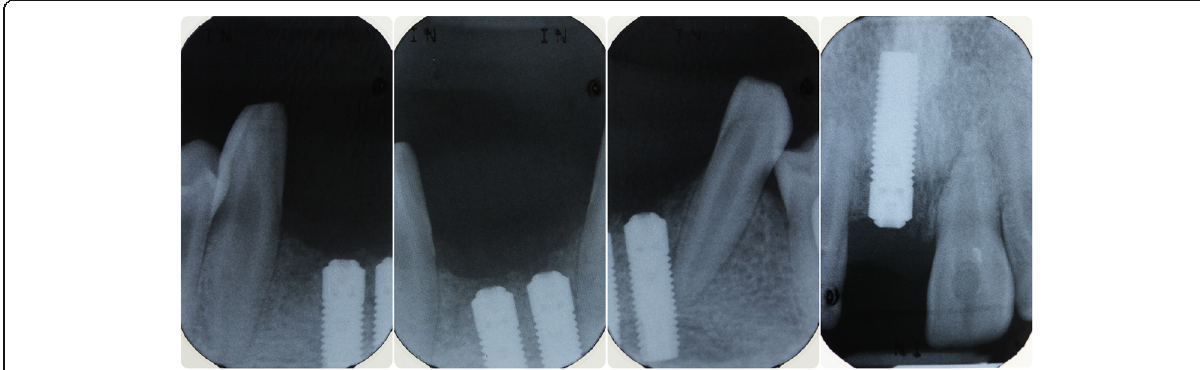
Fig. 3 Placement confirmation. Radiograph of fixtures in 11, 31 and 41 positions confirming